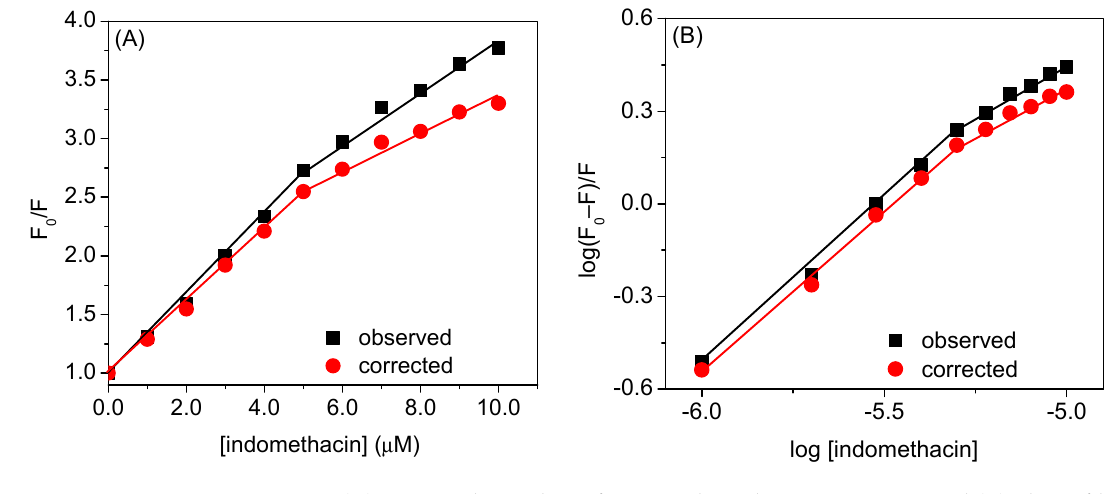
Figure 5. ( A ) Stern–Volmer plots of HSA–indomethacin interaction and ( B ) plots of log (F 0 –F)/F versus log [indomethacin] at the excitation wavelength of 295 nm for the observed and corrected data.